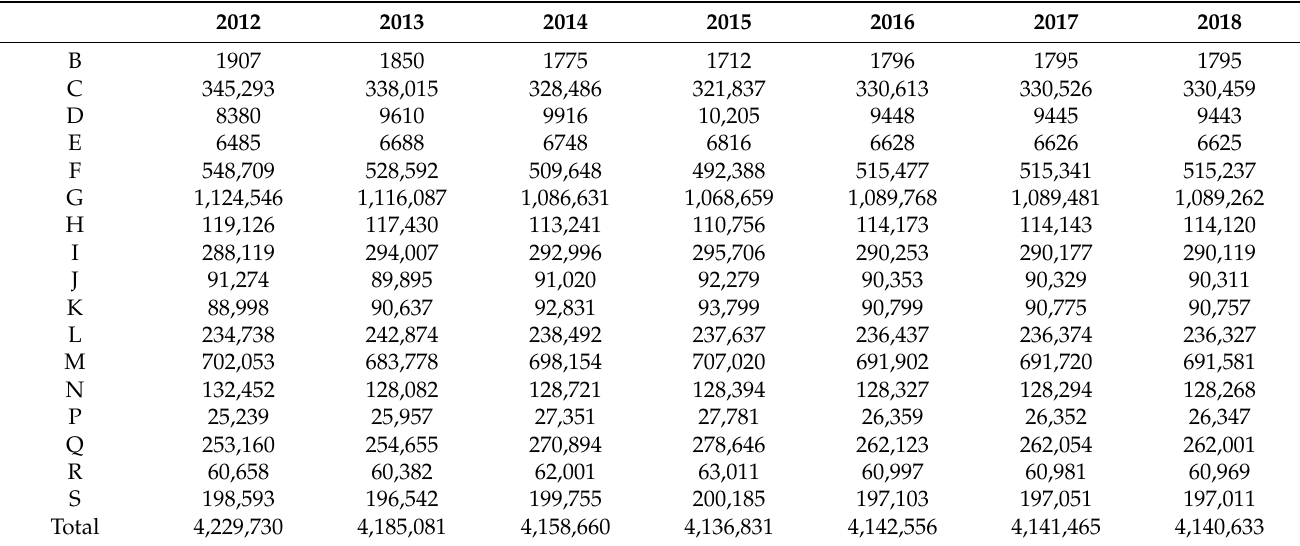
Table 3. Number of micro enterprises in Italy